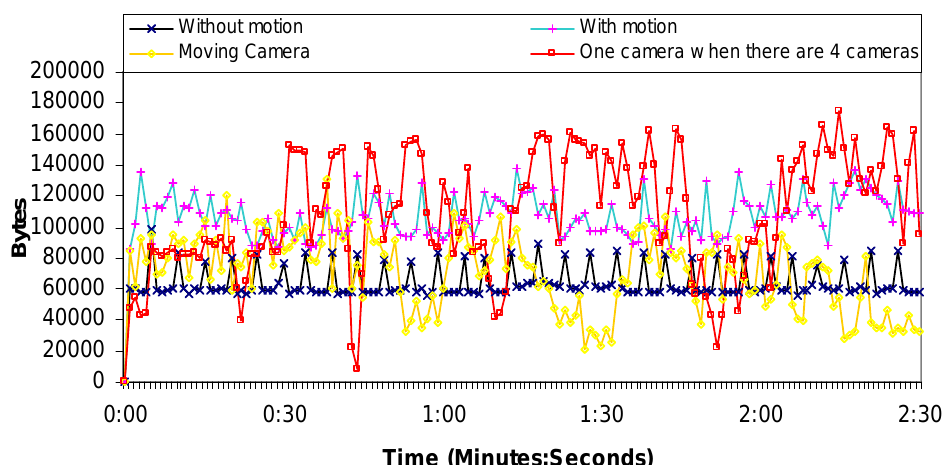
Figure 12. Octets per second obtained by the four